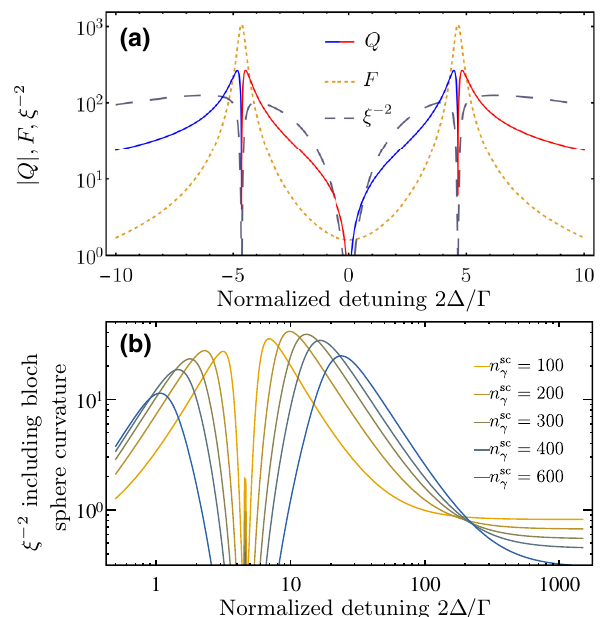
FIG. 2. Illustration of the effects of the atom-light interaction on a CSS. (a) Original CSS on the equator of the Bloch sphere, (cid:4) = 0. (b) The effect of a single-shot optical measurement (see (cid:6) S z the text) with usable QFI F use and total QFI F tot , which displaces the state along S z based on the measurement outcome and yields a resolution beyond the SQL (measurement-based spin squeezing), while broadening it along S y due to the measurement backac- tion. (c) The envelope arising from averaging over many repeated measurements or, equivalently, tracing over the light field, show- ing broadening along S y . (d) Phase shift (cid:7)φ due to the atom-light interaction, Eq. (18). (e) The effect of single-axis twisting with shearing strength Q . (f) The complete final state for cavity spin squeezing including all the discussed effects: first-order phase shift, shearing, and state broadening due to unused information F contained in the light field. The equations below each plot ˜ ˜ give parametric expressions [ S z (θ) ] with θ ∈ [0, 2 π) for S y (θ) , the uncertainty ellipses of the atomic states that are indicated by dotted lines in the same colors as the states. In (c)–(f) the dashed red circle represents the uncertainty circle for the original CSS for